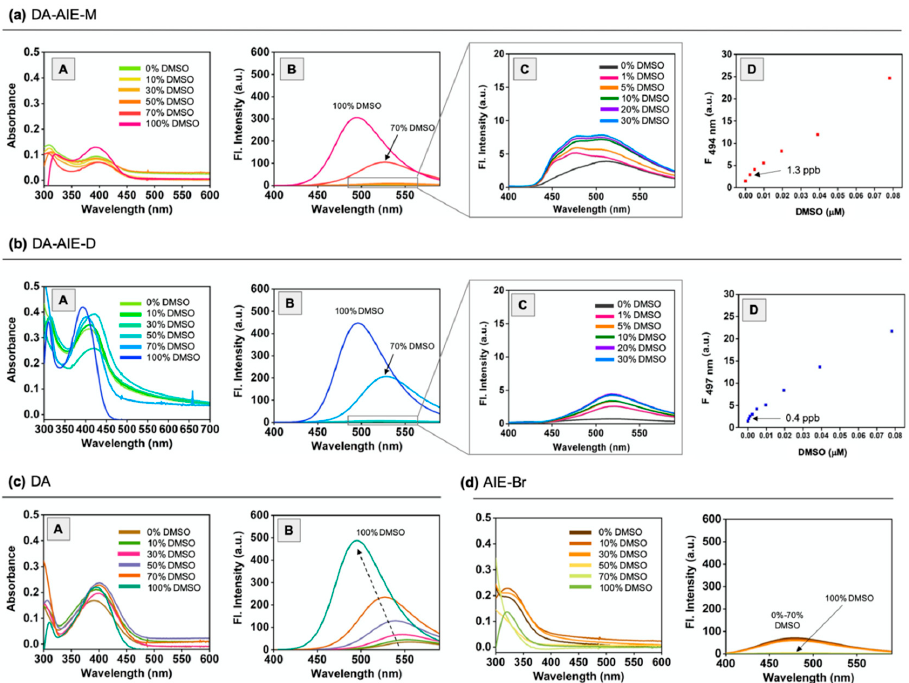
Figure 7. Absorbance spectra (A) and emission spectra (B) of ( a ) DA-AIE-M (10 μ M), ( b ) DA-AIE-D (10 μ M), ( c ) DA (10 μ M), and ( d ) AIE-Br (10 μ M) in DI H 2 O-DMSO mixture (0 – 100%). (C) Enlarged emission spectra of DA-AIE-M and DA-AIE-D in the 0 – 30% range of DMSO. (D) The plot of emission intensity of DA-AIE-M (at 501 nm) and DA-AIE-D (at 513 nm), in contrast to the concentration of DMSO (0 – 0.08 μ M) in DI H 2 O, and measured at 25 °C. The emission spectra were measured under excitation at the maximum absorption wavelength. The mean value of detection limit (ppb unit) was represented and derived from triplicate measurement. Materials 2020 , x , x